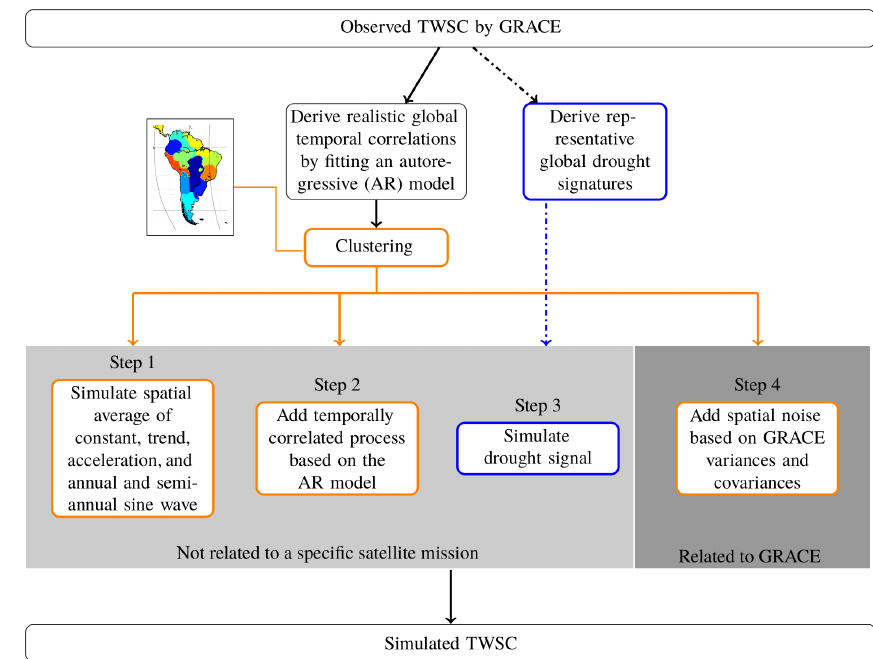
Figure 2. Concept of the synthetic framework to generate synthetic